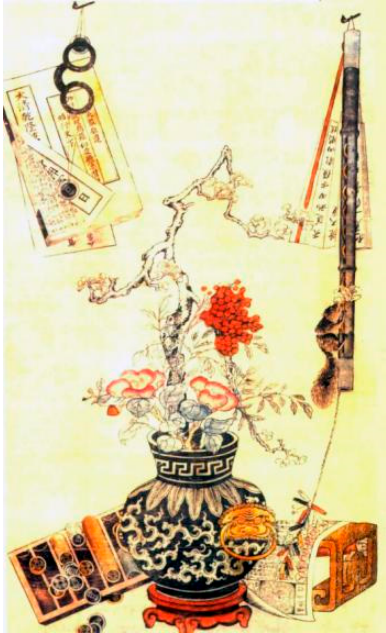
Figure 8. The vase in the Qianlong period.